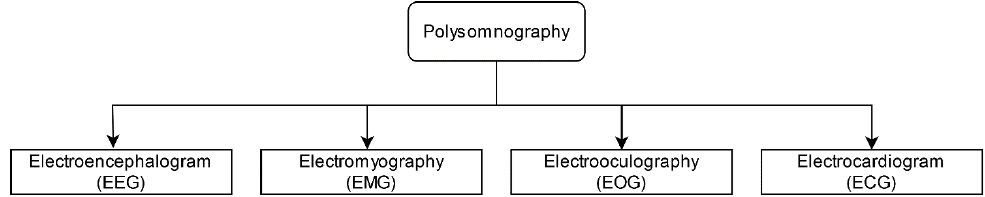
Figure 6. Different categories to measure the sound using polysomnography